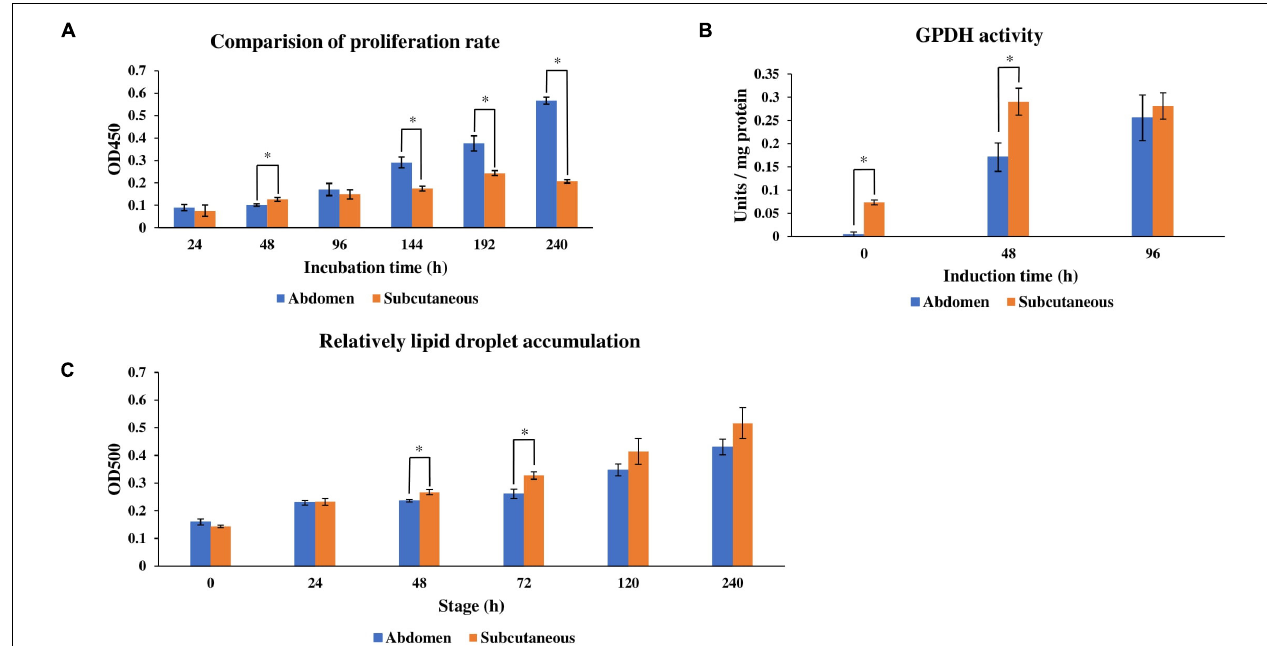
FIGURE 1 | Proliferation rate, GPDH activity, and intracellular lipid droplet accumulation of abdominal adipose and subcutaneous adipose of ducks cultured in differentiation medium (induction). (A) Relative quantification of cell proliferation rate within 24–240 h after induction. (B) Analysis of GPDH activity at 0 h, 48 h, and 96 h after induction. (C) Relative quantification of lipid droplet accumulation within 240 h after induction. The line graph represents the SD of the average ( n = 3). *Indicates that there is a statistically significant difference between abdominal and subcutaneous preadipocytes at the same time ( P < 0.05). The statistics data of subcutaneous preadipocytes in panels (B,C) were cited by Wang et al. (2019).